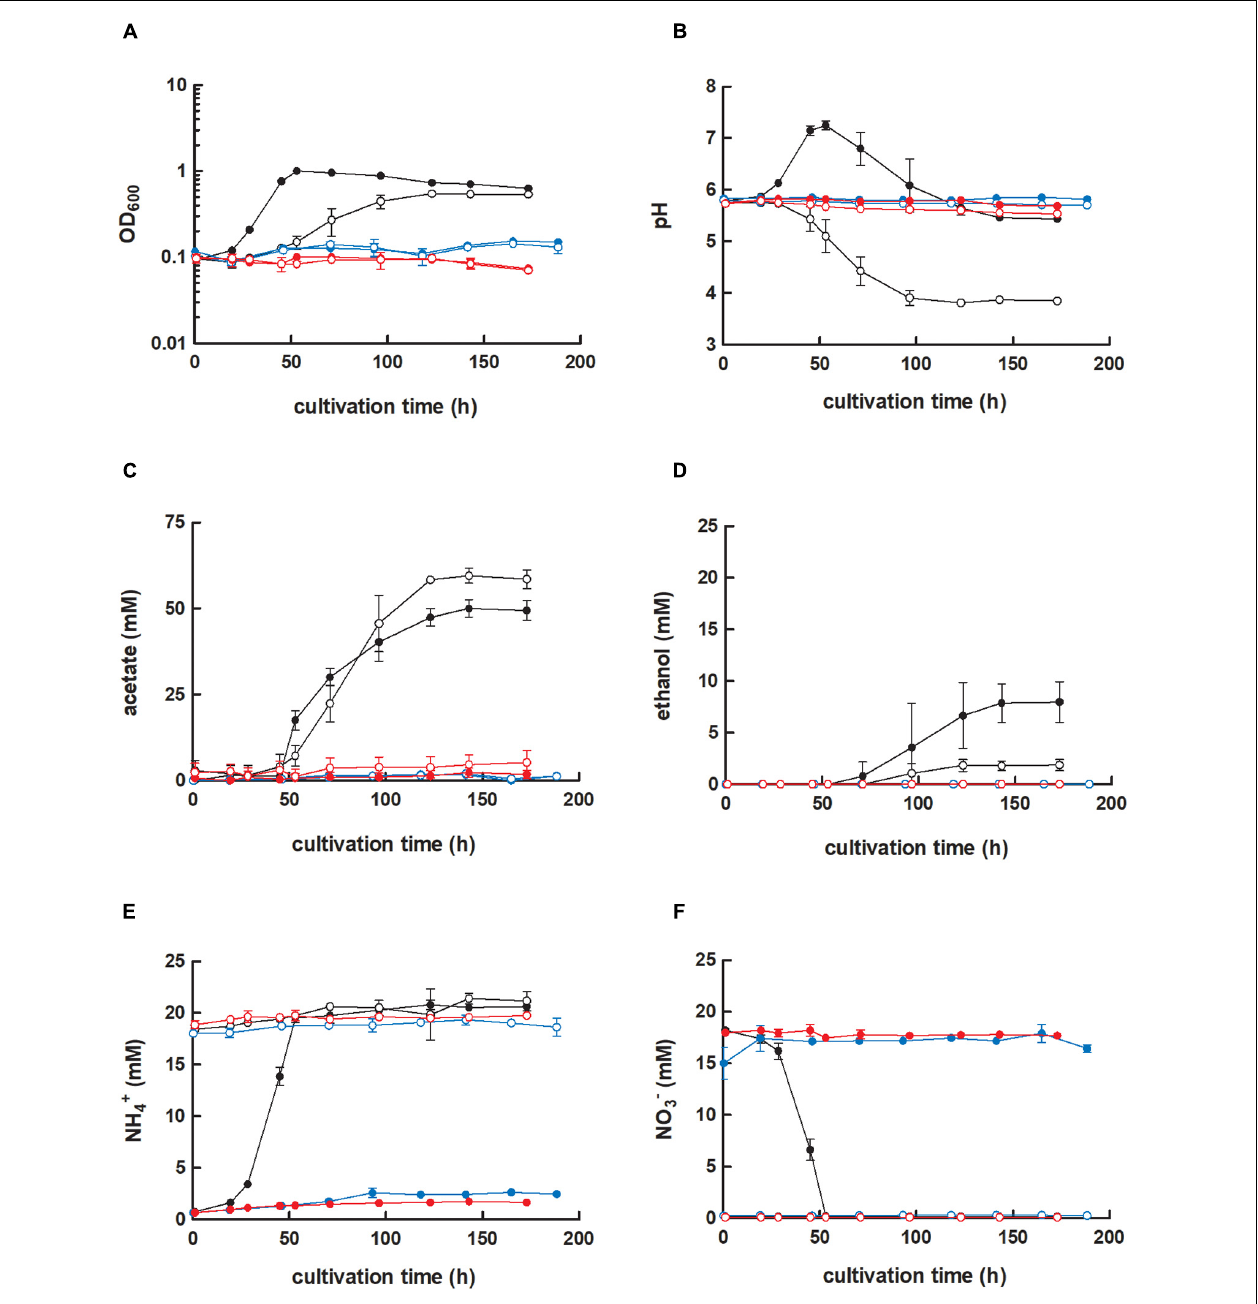
FIGURE 2 | Cultivation of C. ljungdahlii WT, C. ljungdahlii (cid:49) RNF, and C. ljungdahlii (cid:49) rseC in nitrate- or ammonium-containing medium with H 2 and CO 2 . Cultures of C. ljungdahlii strain WT